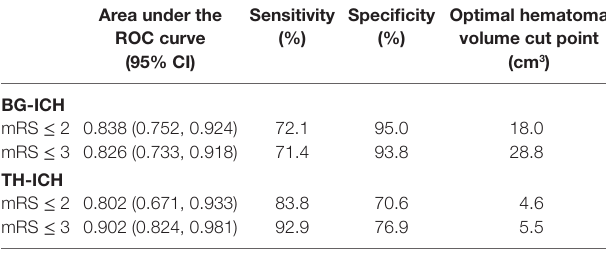
taBLe 2 | Association between hematoma volume and 3-month functional outcome.